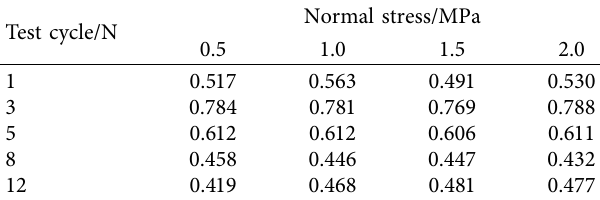
Figure 9: Scanning image of typical joint surface morphology. Table 1: Damage coefficient of JRC by heat-wet cycle.